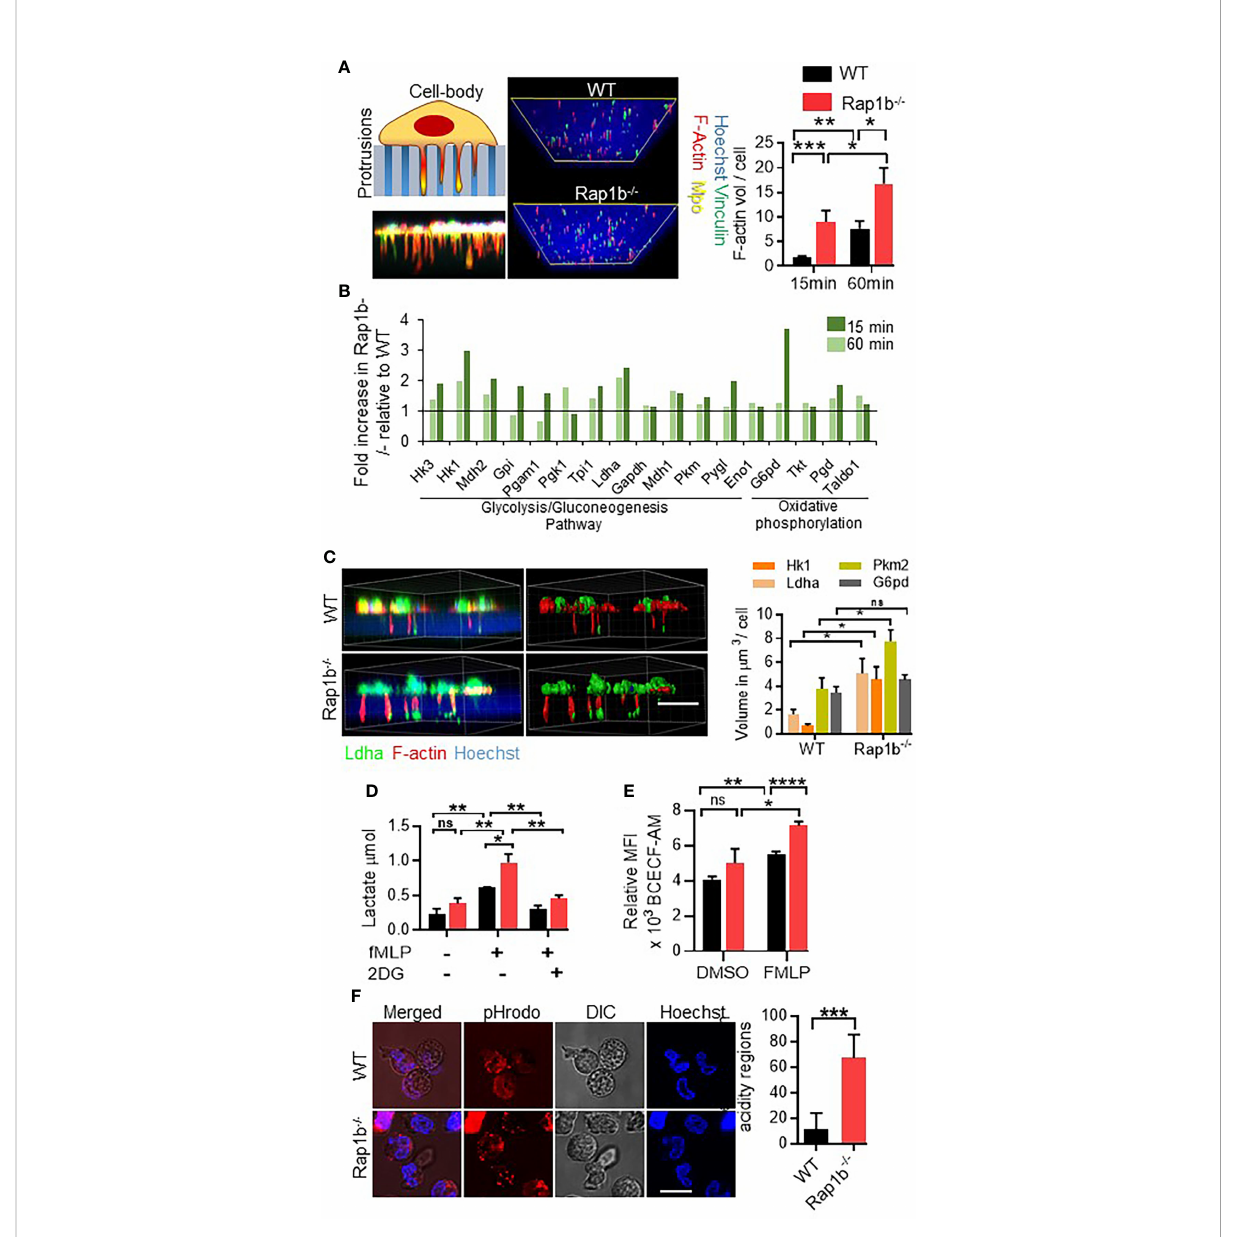
FIGURE 1 Rap1b de fi ciency enhances Ldha activity in neutrophils. (A) , Analysis of neutrophil invasive protrusions after fMLP chemotaxis, over 1µm transwell fi lter. Schematic diagram and representative confocal z-stack image showing trapped neutrophil protrusions in the porous membrane of transwell fi lter (left panel). Representative Z-stack sections from protrusion fractions of Rap1b -/- and WT neutrophils were rebuilt using Imaris software (right panel). Images are the view of the protrusions from the bottom of the fi lter. Bar graph represents the volume of F-actin positive protrusions per 100 WT and Rap1b -/- neutrophils, at 15min and 60min time points. (n=8 independent experiments, average of 60cells each group each condition analyzed). (B) , Mass spectrometric analysis showing percent change in metabolic enzymes in the protrusive fractions of Rap1b -/- and WT neutrophils at 15 min and 60 min time points (n=1, pooled neutrophils from 2 mice each condition). (C) , Immunostaining analysis of fi xed WT and Rap1b -/- neutrophils after 15 min of fMLP chemotaxis on 1µm transwell fi lters. Representative fl uorescent image showing localization of Ldha (green) along with F-actin (red) positive protrusions (Left). Image rebuilt using Imaris on which volume quanti fi cation was performed (Right). Bar graph showing relative volume of Ldha, G6pd, Pkm2 and Hk1 positive staining in the protrusion fraction. (n=3 independent experiments. Average of minimum 100 cells/group/experiment). (D) , Quanti fi cation of Lactate release by adherent neutrophils after fMLP stimulation (n=3 independent experiment). (E) , Isolated neutrophils were incubated with BCECF-AM for 10 min at 37°C in the presence or absence of FMLP and pHi was measured using fl ow cytometry. (n=3 mice per group per condition. 3 independent experiments) (F) , Representative images showing region of intracellular acidi fi cation by pH sensitive dye, pHrodo, in live WT and Rap1b -/- neutrophils after 15min offMLP stimulation. Bar graph represents quanti fi cation of percentage positive cells per fi eld (n=6 fi elds under 60x objective per condition; 2 independent experiments). Means ± SEM. For all panels: *P < 0.05; **P < 0.001; ***P < 0.0004; ****P < 0.0001; NS, not signi fi cant using unpaired Student ’ s t test. Scale bar;